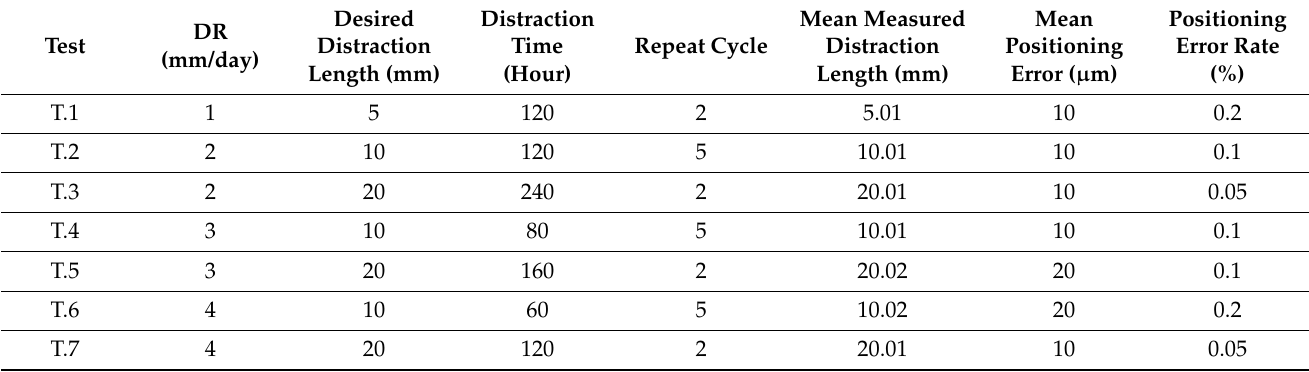
Table 1. The set working parameters in the positioning test and the obtained results.